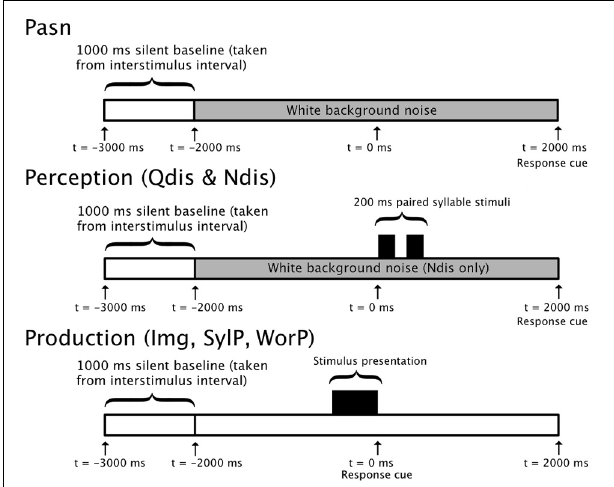
FIGURE 1 | Single-trial timelines for perception and production conditions. Timelines for 5000ms ( − 3000 to 2000ms) in passive noise condition (Pasn), discrimination conditions (Qdis & Ndis), and production conditions (Img, SylP, and